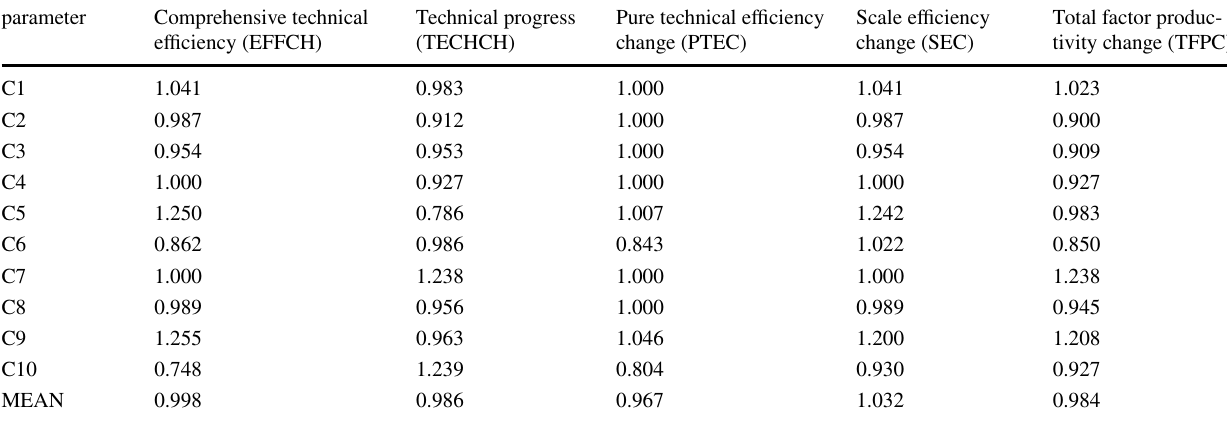
Table 3 Overall evaluation results of technical innovation efficiency of 10 production plants under Malmquist model in